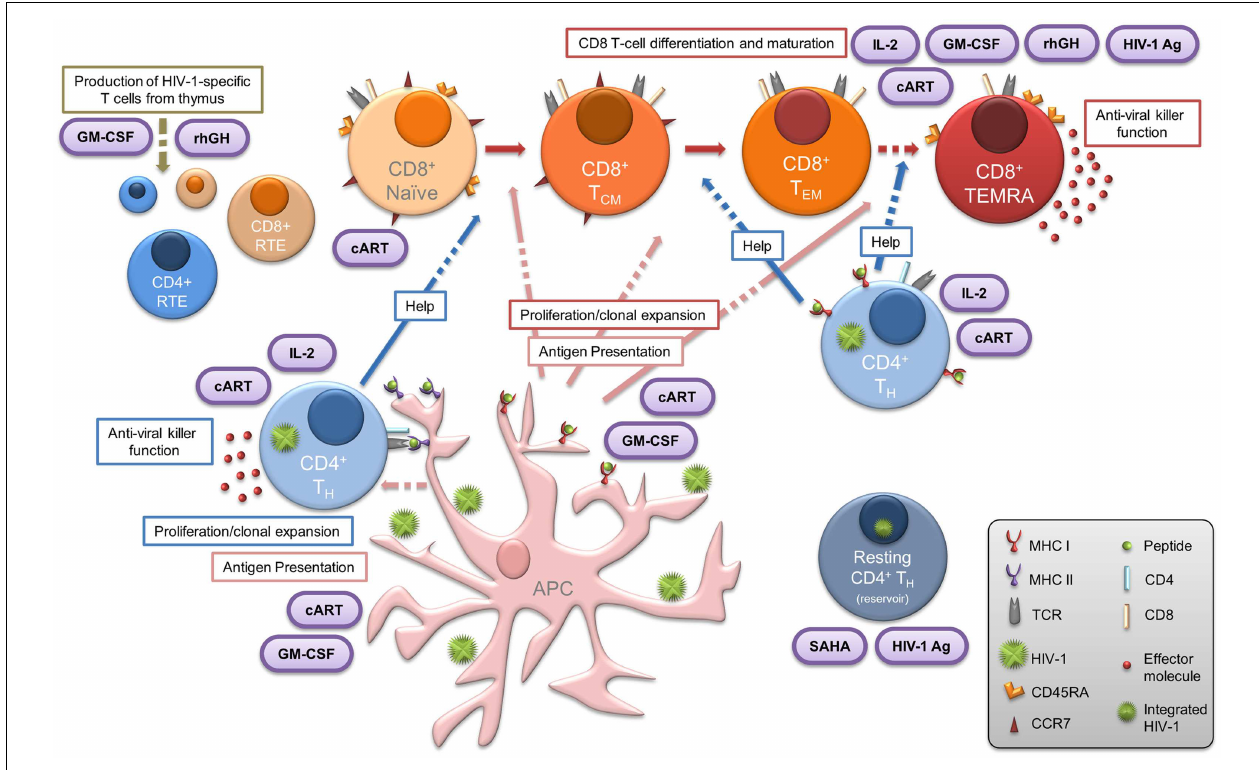
chronic HIV-1 infection may enable the induction of virus-specific CD4T cells essential for the subsequent “kick-start” and expansion of specific CD8T cells.This provides a window of opportunity to steer the immune system to the advantage of the patient and achieve LTNP status or functional cure. APC, antigen-presenting cell; cART, combination antiretroviral therapy; CTL, cytotoxicT lymphocyte; GM-CSF, granulocyte macrophage colony stimulating factor; HIV-1 Ag, HIV-1 antigen; HTL, helperT lymphocyte; IL-2, interleukin-2; NK, natural killer; rhGH, recombinant human growth hormone; RTE, recent thymic emigrants; SAHA, suberoylanilide hydroxamic